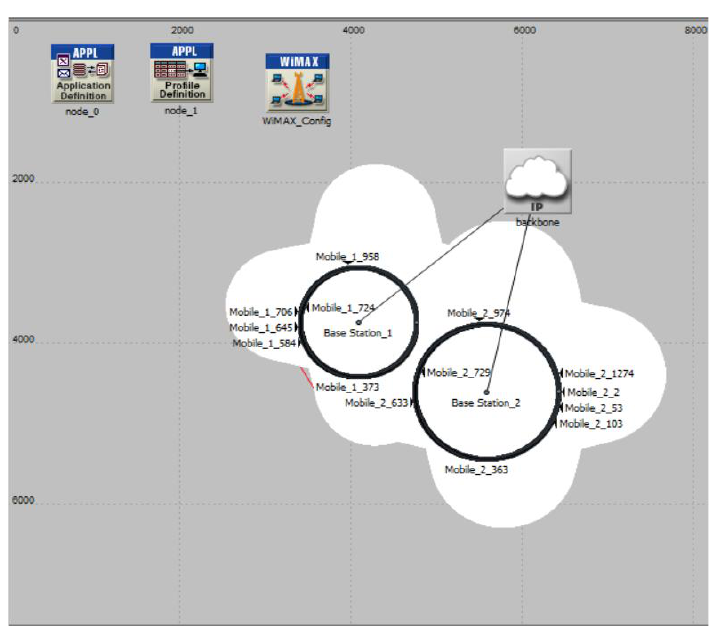
Fig. 1. The proposed design